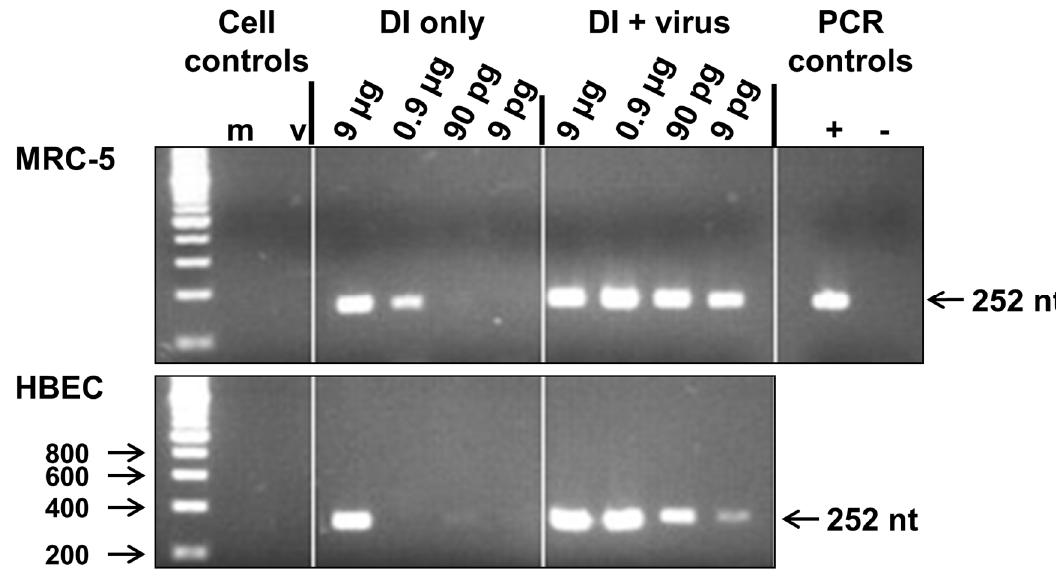
Figure 1. Replication of 244/PR8 defective interfering (DI) RNA in MRC-5 and human bronchial epithelial (HBE) cells in culture. RNA was prepared from cells inoculated with 9 pg, 90 pg, 0.9 µ g or 9 µ g 244/PR8 DI virus alone or with 244/PR8 DI and infectious A/WSN/33 influenza viruses together, as indicated. 244/PR8 RNA was detected by reverse transcription PCR (RT-PCR) amplification and the 252 nucleotide (nt) product was identified by agarose gel electrophoresis. RNA used for RT-PCR amplification in lane m was extracted from mock infected cells and RNA in lane v was extracted from virus infected cells. Positive and negative PCR controls were generated using purified 244/PR8 DI RNA (+) or by omitting RNA from the RT-PCR reaction ( − ). A DNA size marker ladder is in the left-hand lane. The size of fragments (nt) is indicated.